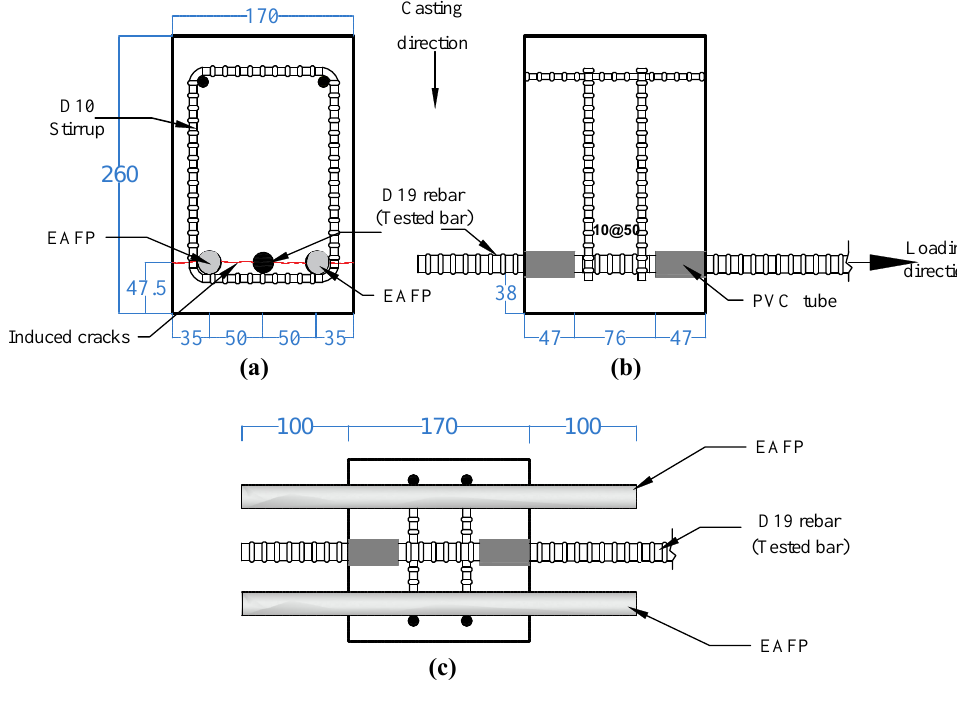
( b ) Figure 7. Concrete cracking with an EAFP: ( a ) cracking process; ( b ) expansion agent filling. 2.5. Loading and Measurement Method After the target-induced crack width is obtained, the specimen is subjected to pull- out loading. Figure 8 shows the general setup for the pull-out test. Before loading, the excess part of the aluminum pipe located at the loading end was cut off. Then the speci- men was placed on the fixed head cross of the universal testing machine and subjected to Expansion agent Aluminum pipeInduced crack Stirrup